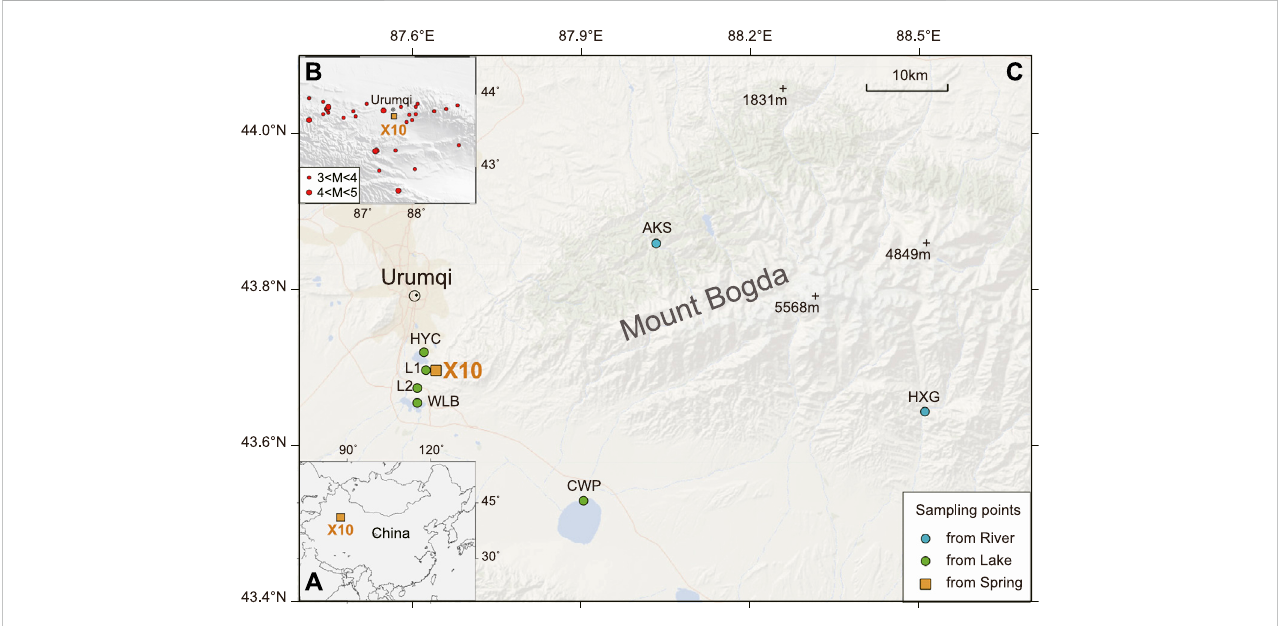
FIGURE 1 Overview of the study area. (A) Location of the monitored spring is displayed with a yellow square. (B) Red circles represent the epicenters of the main historical earthquakes that have occurred in the area. (C) The green and blue circles represent lake and river water sampling points, respectively.